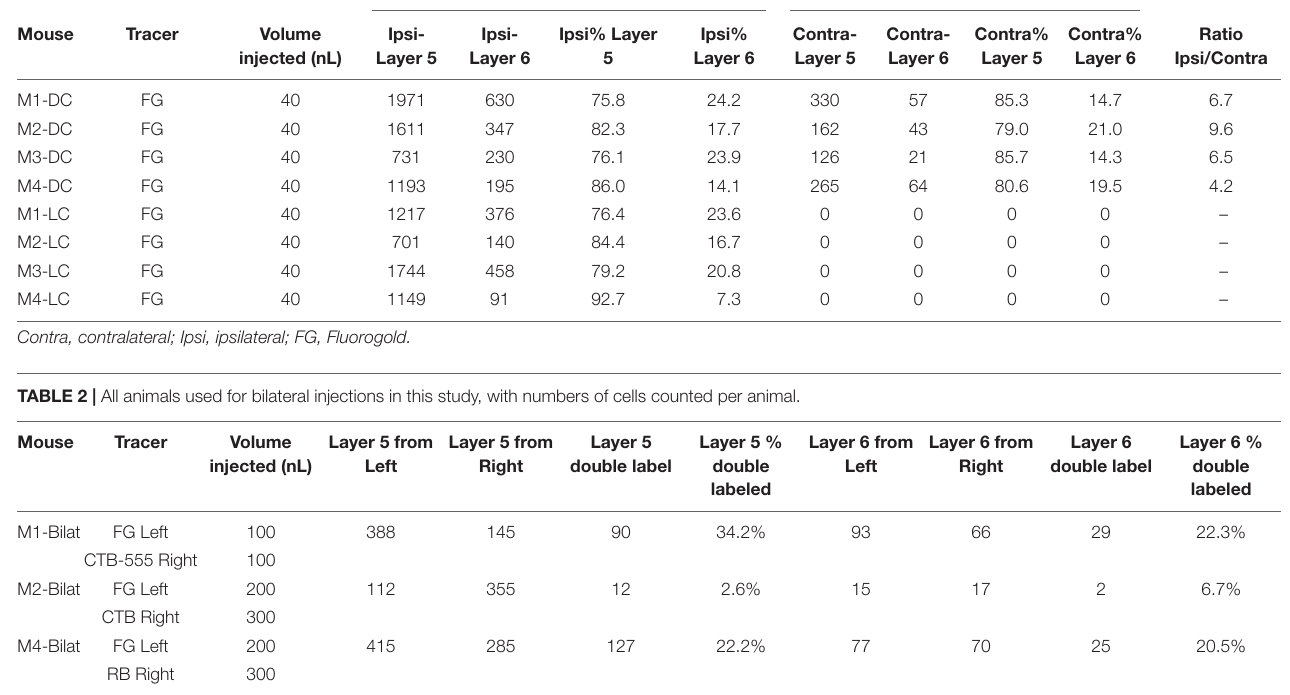
TABLE 1 | All animals used for unilateral injections in this study, with numbers of cells counted per animal. Ipsilateral Contralateral